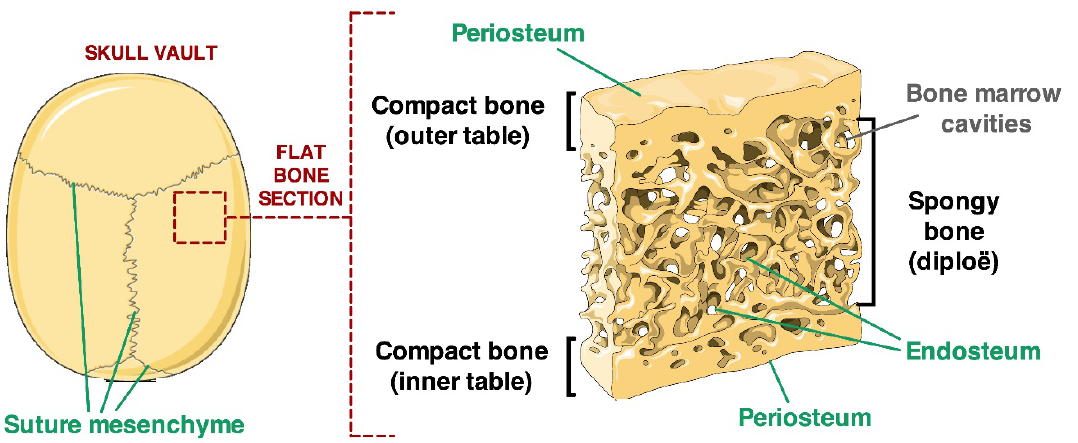
Figure 1. Visual description of the architecture of calvarial flat bone. Two sheets (outer and inner tables) of compact bone enclose a layer of spongy bone (diploë). Green arrows highlight the endosteal, periosteal and inter-suture locations of MSC niches (figure modified from https://smart.servier.com/).